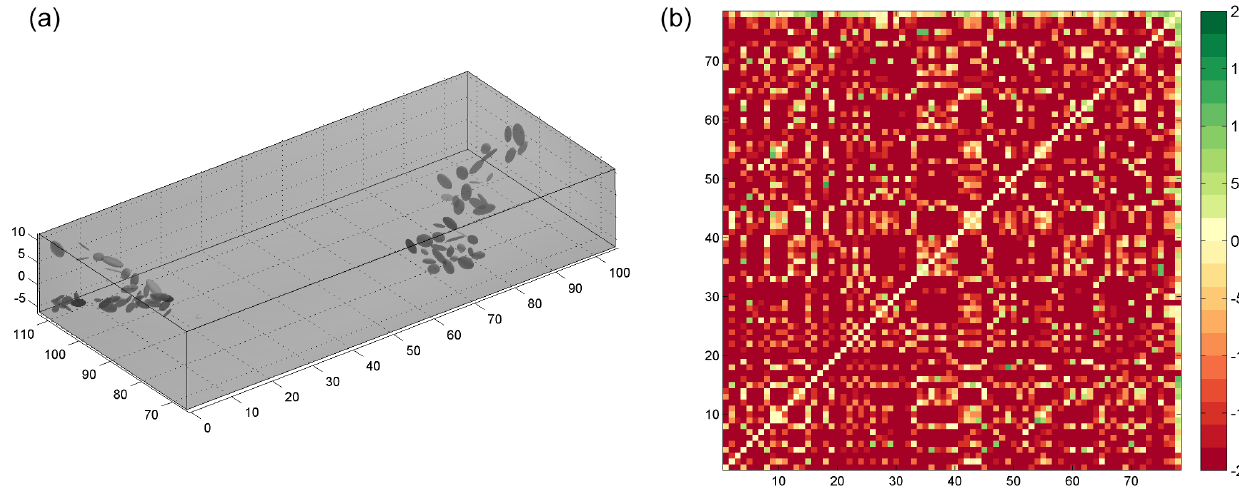
Figure 3. (a) The initial proto-clusters for the synthetic dataset given in Fig. 2a. Notice that the number of clusters (78) includes the uniform background kernel as well. (b) The BIC gain matrix calculated for all possible merging of pairs of